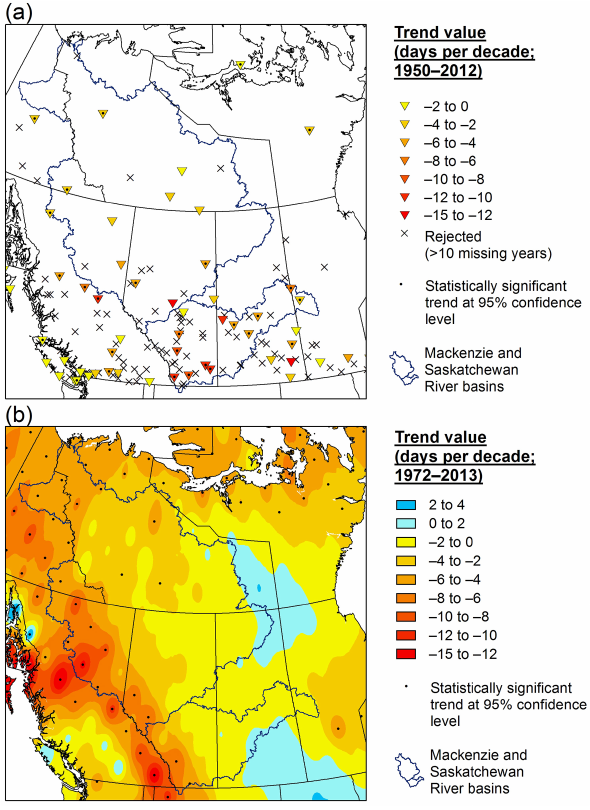
Figure 6. (a) Trends in annual snow cover duration for the pe- riod 1950–2012 based on surface observations as part of the Cana- dian daily snow depth data set. Stations were rejected in cases where the amount of missing data exceeded 10 years. (b) Trends in spring season (February–August) snow cover duration for the period 1972–2013 based on the NOAA weekly snow cover prod- uct from the Rutgers University data set (Rutgers data documen- tation at http://climate.rutgers.edu/snowcover/docs.php?target=vis). In (b) , the spatial patterns are based on inverse distance weighting of the points in a 190.5km polar stereographic grid. Data and results provided by R. Brown, Environment